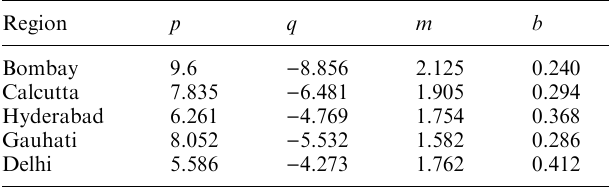
Table A2. Parameters of fitted log-normal distributions for the height H (km) of cumuli estimated from p and q (monsoon season)